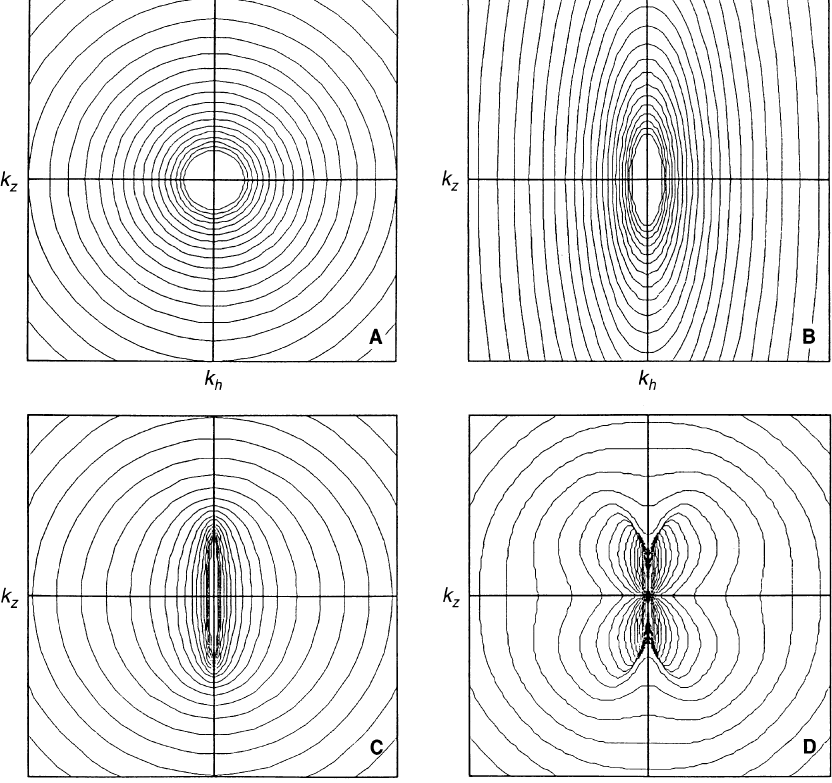
Fig. 1A–D. The scheme of the level line projections of a F (cid:133) k z ; k h (cid:134) surface on the coordinate plane k h Ok z . A LI inhomogene- ities, B LASIs with a constant anisotropy (cid:103) (cid:136) 3, C LASIs with variable anisotropy, 0 (cid:103) (cid:136) 1 (cid:135) q (cid:255) 6 ; E (cid:133) q (cid:134) (cid:136) q (cid:255) 3 , and D LASIs that correspond to the family of Eq. (6), (cid:103) (cid:133) q (cid:134) and E (cid:133) q (cid:134) are the same as for